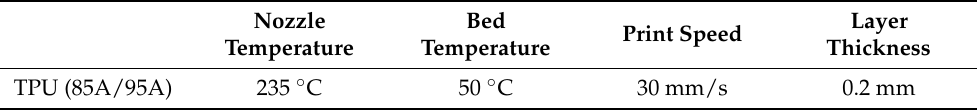
Figure 6. 3D printed lattice structure ( left ) and instrumented toy assembly ( right ). Table 1. Print parameters for the fabrication of lattice